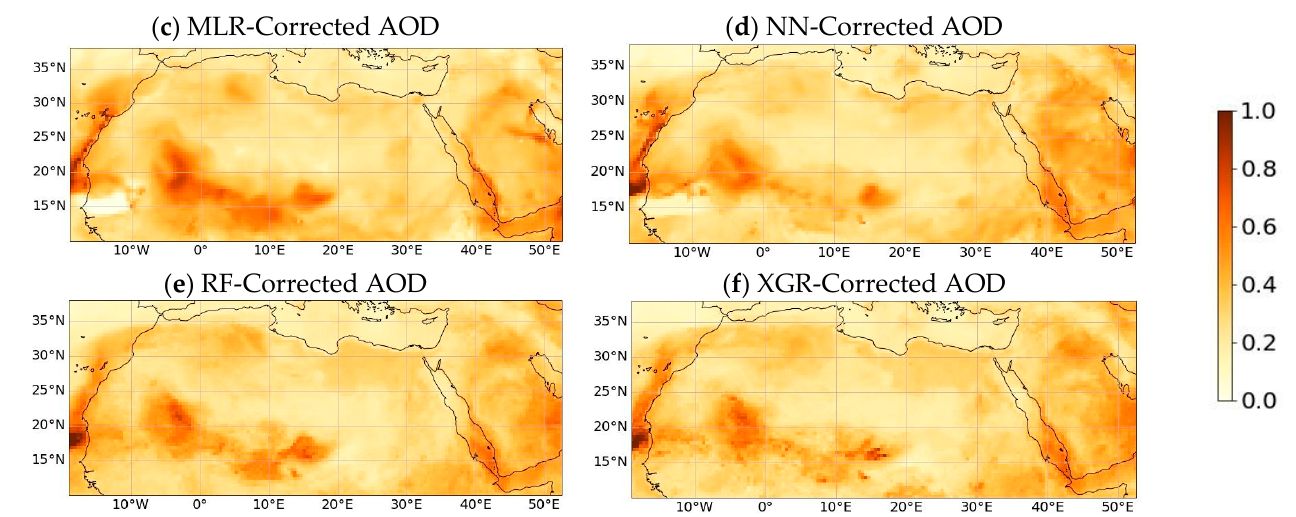
Figure 4. Horizontal distribution of AOD at 550 nm on 30 September 2021 (not used for training) from ( a ) MODIS satellite observations, ( b ) raw CHIMERE simulation, and bias-corrected AODs using the ( c ) MLR, ( d ) NN, ( e ) RF, and ( f ) XGB models. The AOD predictions of the remaining days are available at the link provided in the data availability clause.